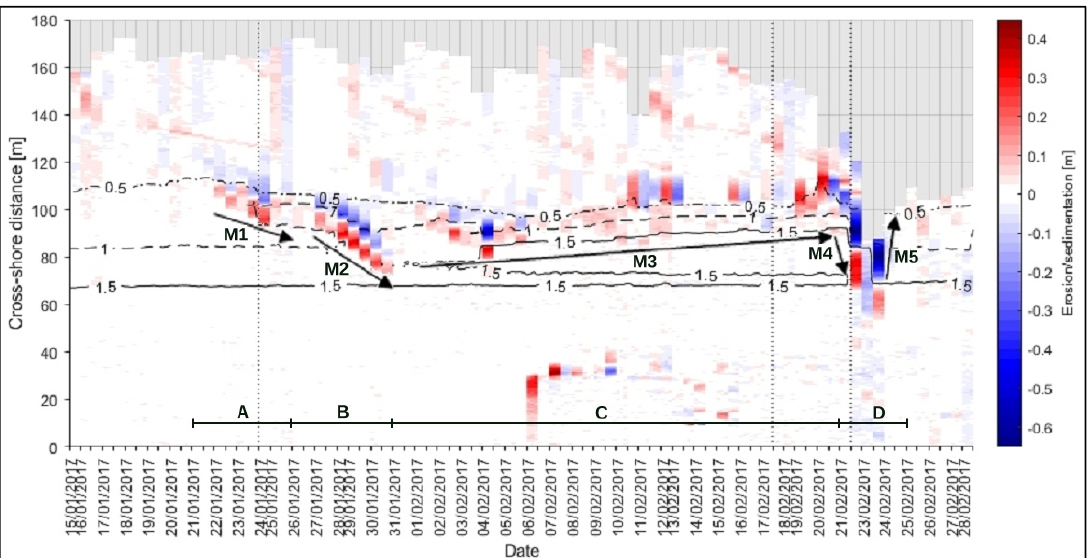
Figure 8 . Sedimentation and erosion stack plot in the period from 15 January to 26 February 2017, based on day-to-day beach height differences. The black contour lines indicate isobaths at +0.5 m, +1 m, and +1.5 m NAP. The vertical dotted lines indicate the date of the missing low water periods from which the third line represents two missing low water periods. The arrows with numbers M1 to M5 indicate bar movements in the development and destruction of the intertidal bar, while the periods are indicated at the bottom.